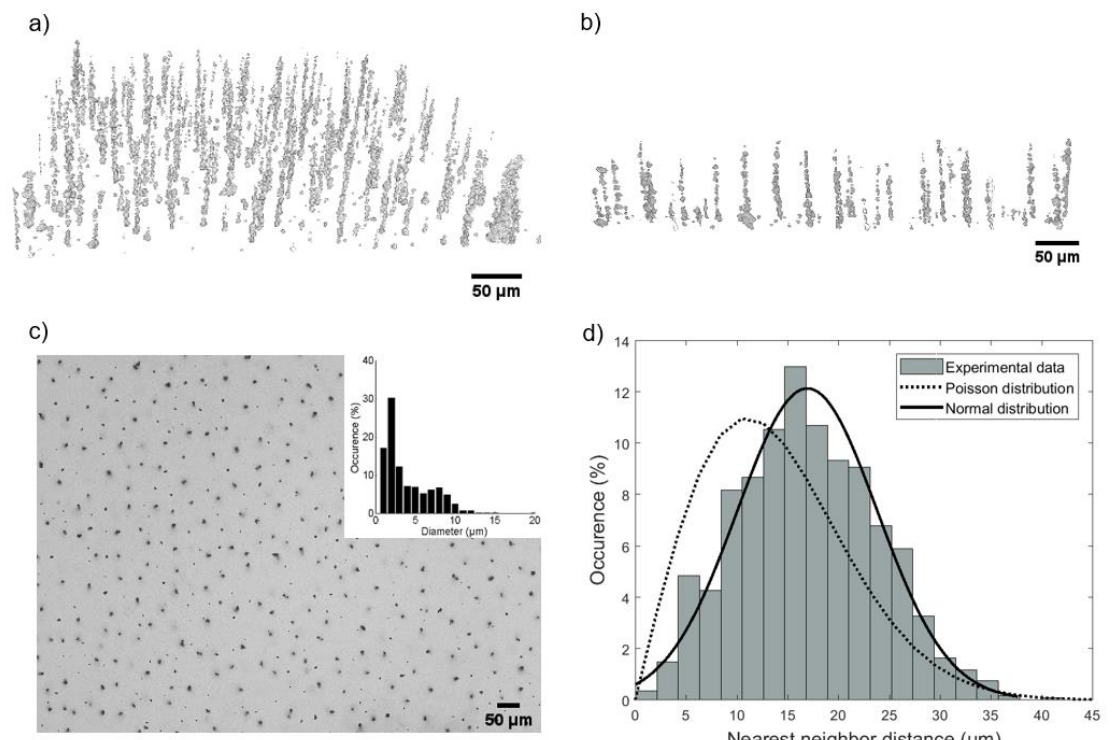
Figure 2. ( a ) 2% NdFeB particle organization in PDMS membrane from X-ray tomography reconstruction of a 510 × 510 × 120 μm 3 volume. ( b ) Section view of the chain-like organization of the 2% NdFeB particles obtained from X-ray tomography reconstruction of a 100 × 510 × 120 µm 3 volume. ( c ) Microscope image of the micro-magnet array (top view), and (inset) the micro-magnet diameter distribution. ( d ) Nearest neighbor distance distribution. The experimental distance, measured from brightfield microscopy observation (0.8 mm 2 images), followed a normal distribution and not a Poisson distribution (random distribution of N = 1225 particles in a 0.8 mm 2